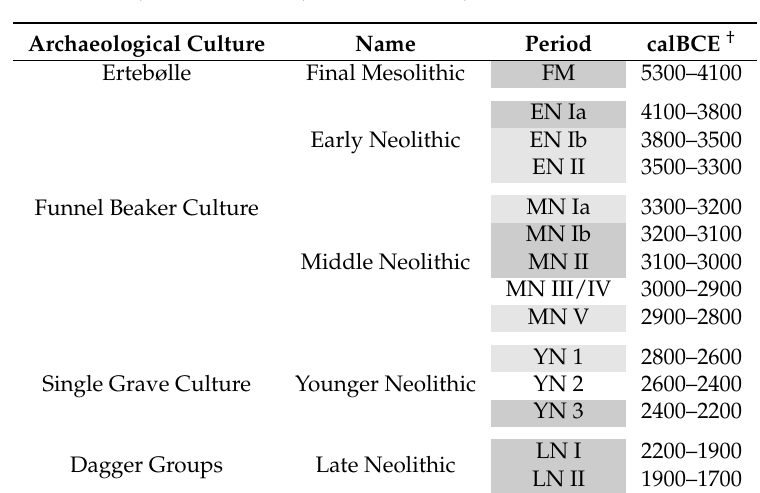
Table 1. Neolithic chronology in Wagrien. Main transformations (gray shaded) took place between FM and ENIa; ENIb and ENII; MNI and MNII; MNV and YN1; YN3 and